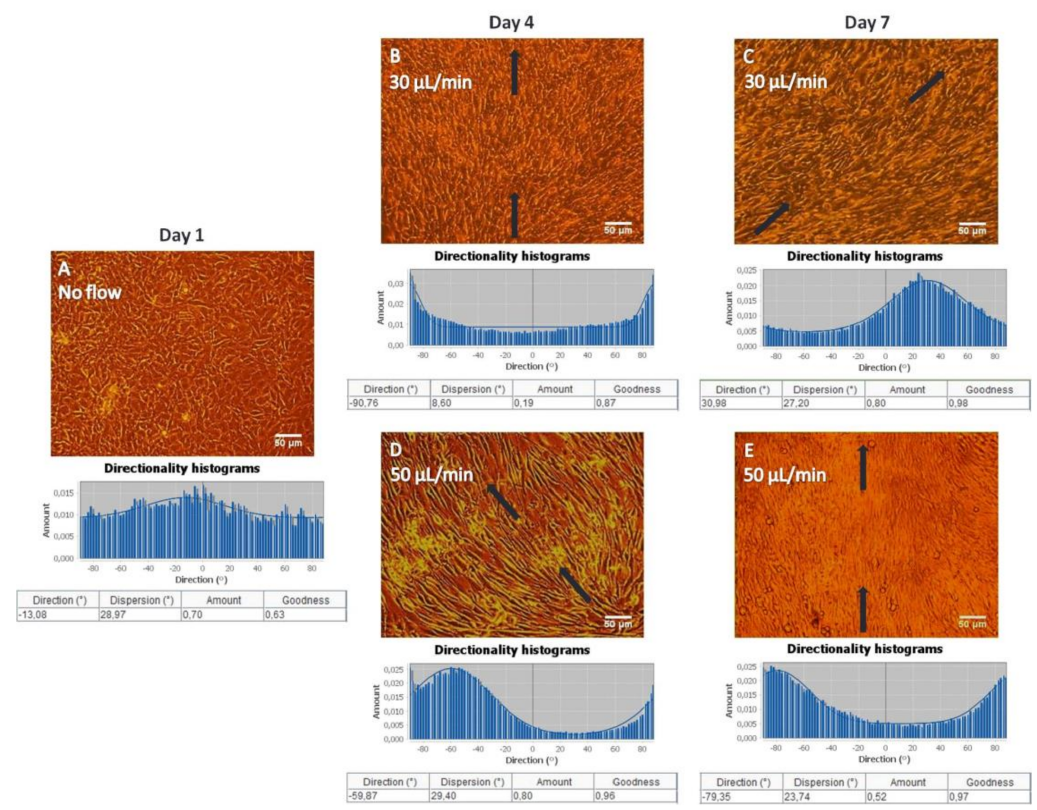
Figure 2. Morphology of MC3T3-E1 cells inside the flow perfusion culture system using gelatin substrates under static conditions ( A ), and under flow conditions applying 30 ( B , C ), and 50 µ L/min ( D , E ) visualized by optical microscopy (ten-fold magnification, the scale bars represent 50 µ m). The black arrows represent the direction of the flow. Directionality histograms and tables with the statistics generated by means of the Fiji ImageJ plug-in “Directionality” [25] are presented directly under the optical microscopy images ( A – E